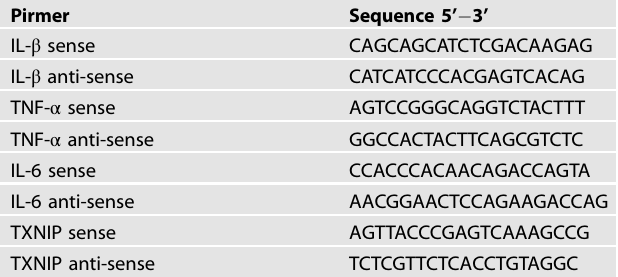
Table 1. The primers used in